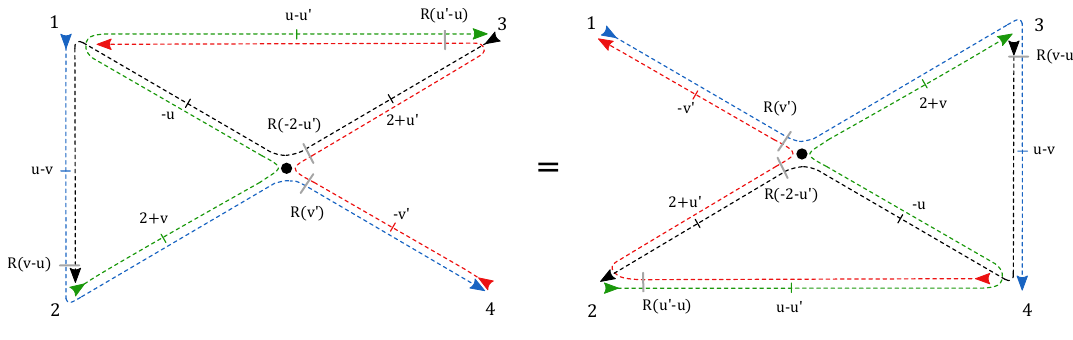
Figure 10 . Diagrammatic form of the interchange relation